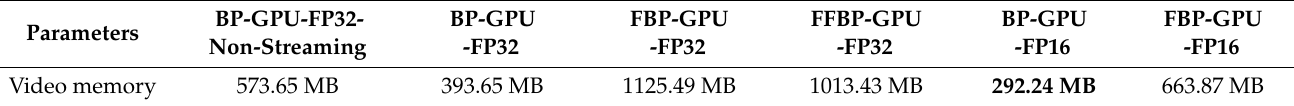
Table 8. Occupancy analysis of video